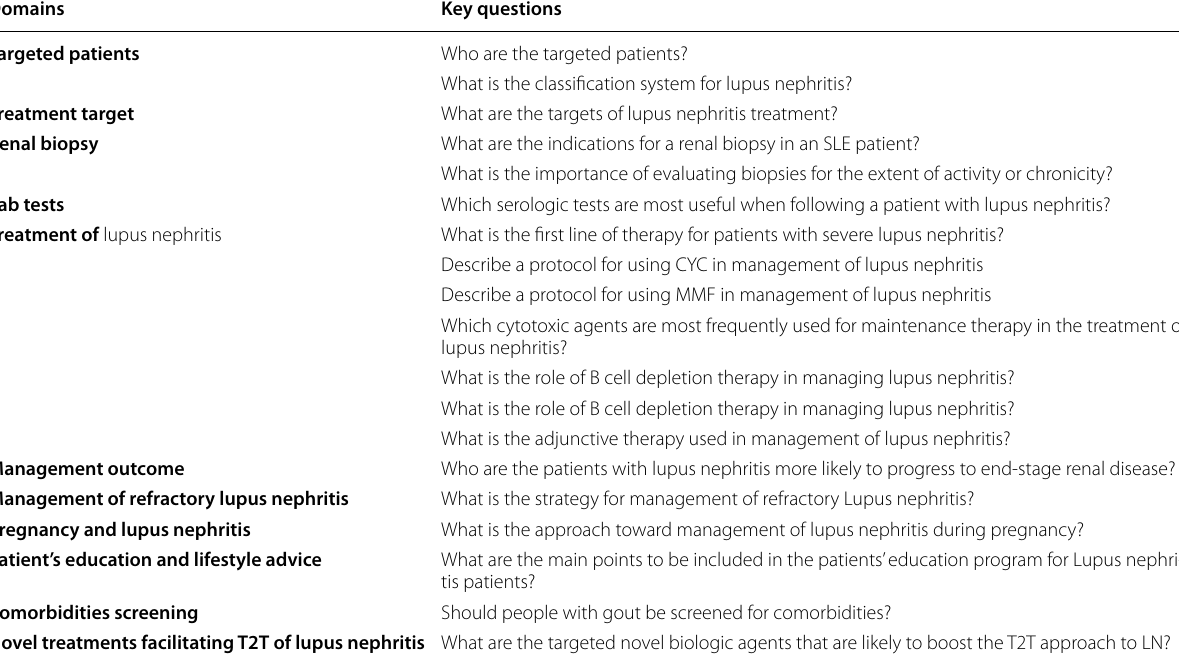
Table 1 Key Clinical Questions for Treat to Target management approach for lupus